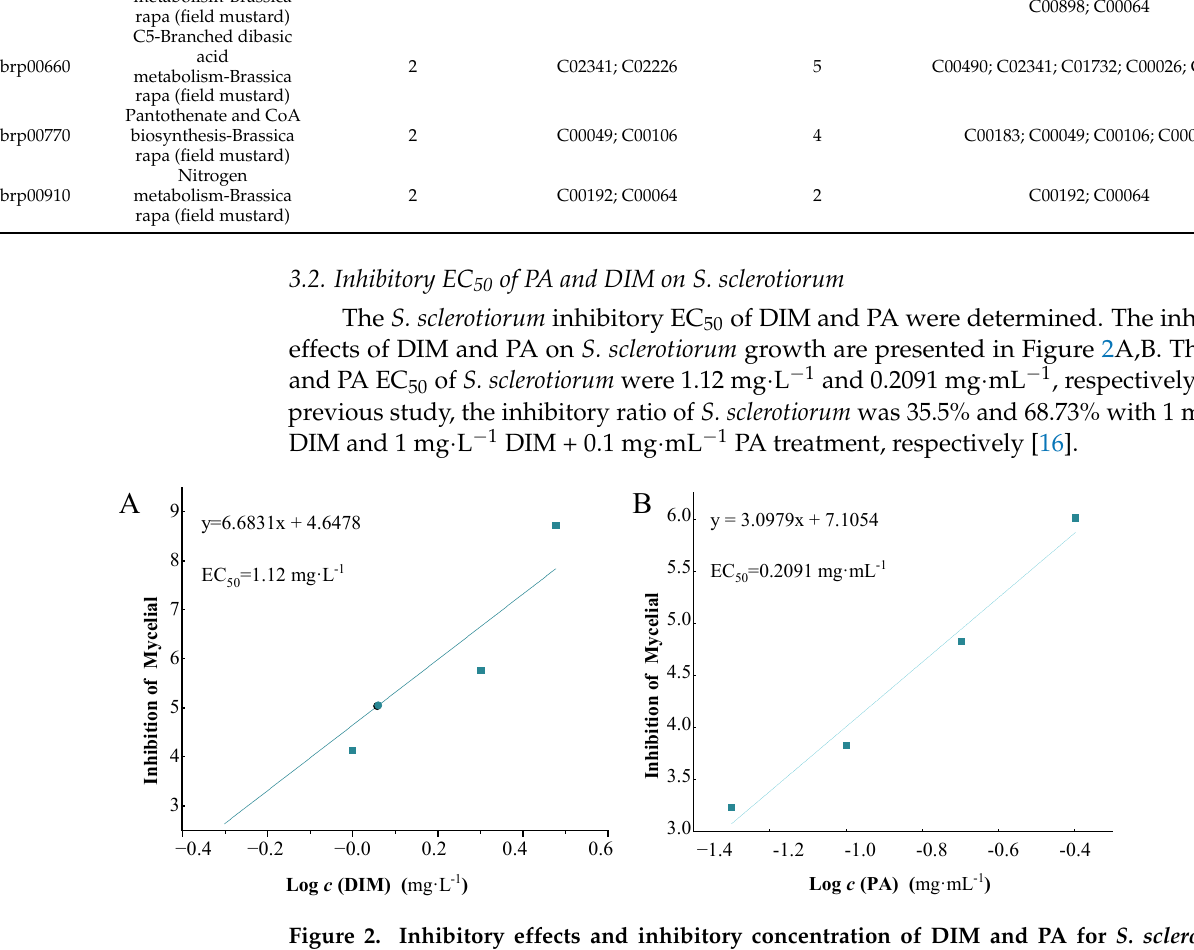
Table 3. Combined inhibition of different concentration of DIM and PA on S. sclerotiorum growth.